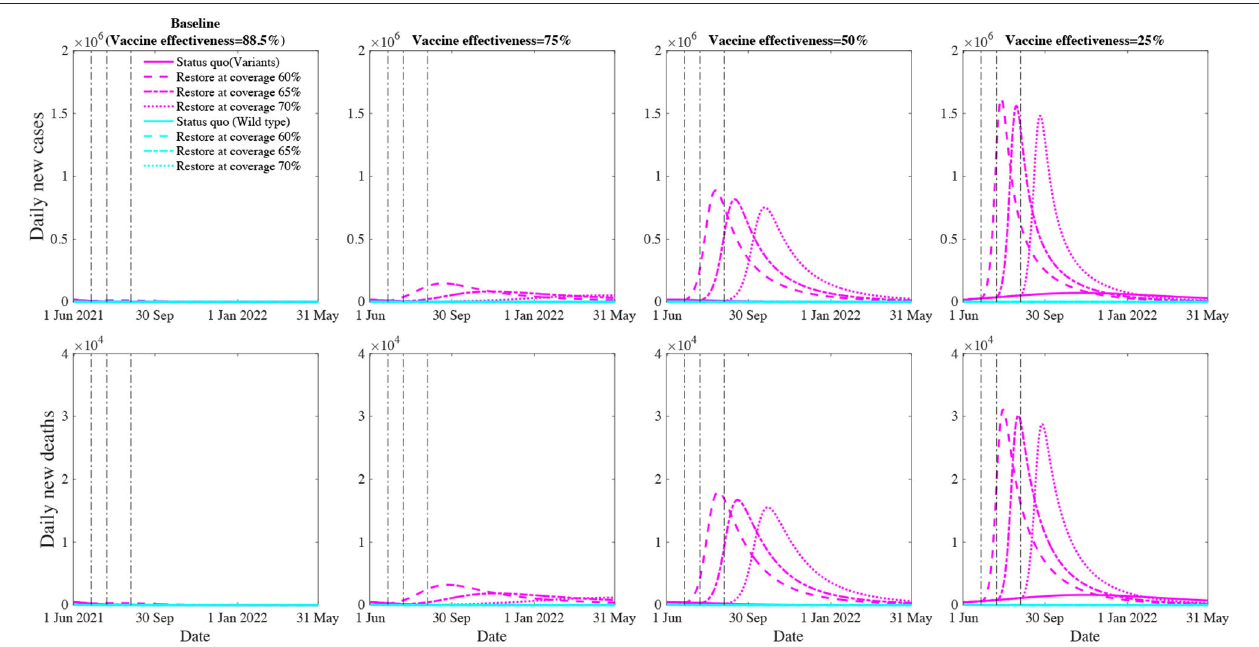
FIGURE 3 | Projected COVID-19 new cases and deaths with social restoration at vaccination coverage of 60, 65, and 70% level over the next 12 months. The first row represents the daily number of new infections whereas the second row represents daily number of deaths. The columns represent an overall vaccine effectiveness of 88.5% (estimated effectiveness for the variant), 75, 50, and 25%, respectively. The magenta and cyan lines (solid, dashed, dash-doted, dotted) denote various restoration scenarios for the wild type and COVID-19